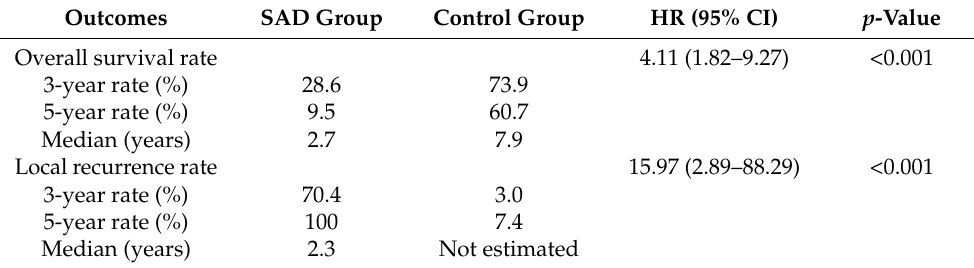
Figure 2. Kaplan–Meier curves for the local control rates in the SAD and control groups. SAD: systemic autoimmune disease.